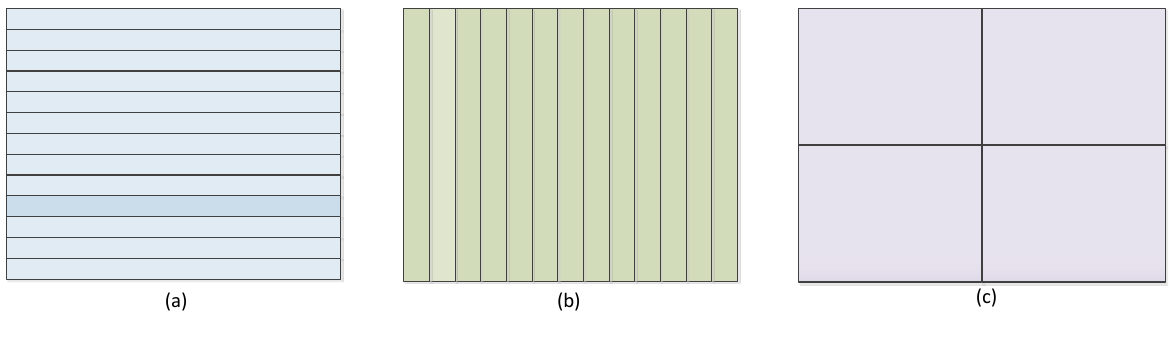
Figure 1. ( a ) Row partitioning; ( b ) Column partitioning; ( c ) Block